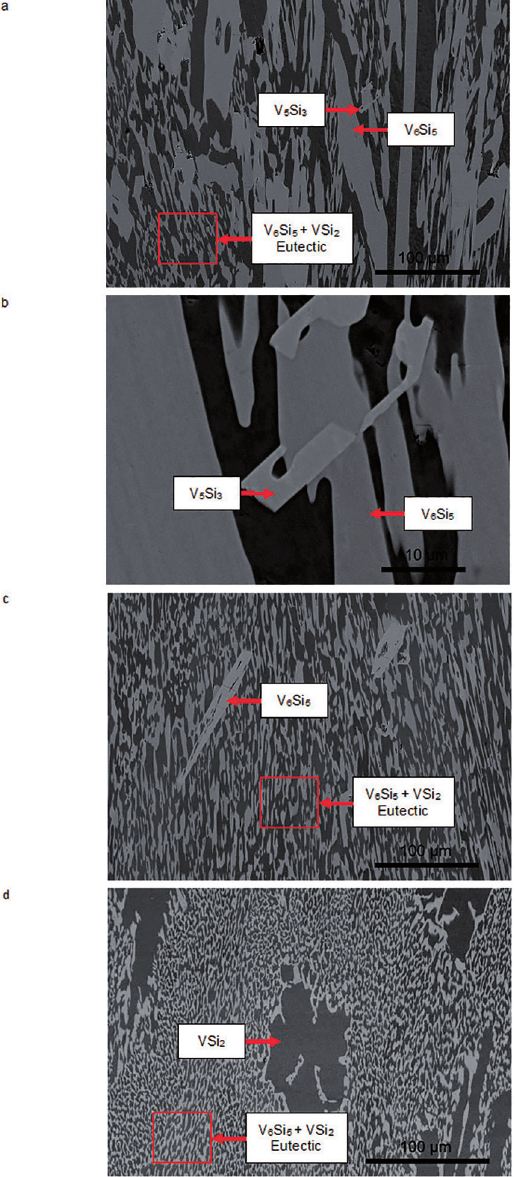
Figure 4: SEM/BSE micrographs of the: (a,b) V55.7Si, (c) V57.7Si and (d) V58.7Si as-cast alloys.